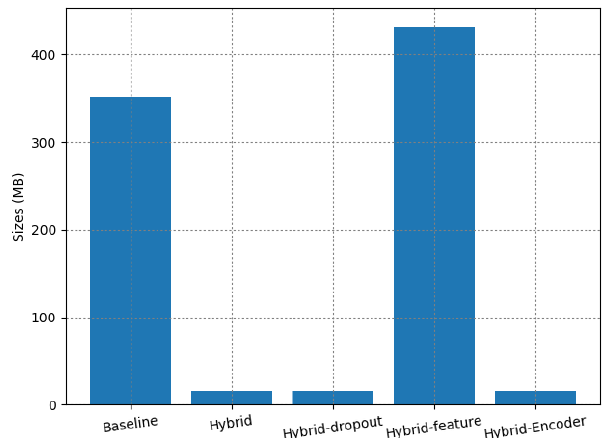
Figure 5. The model sizes. After freezing the models, we measure the stored file size of weights.